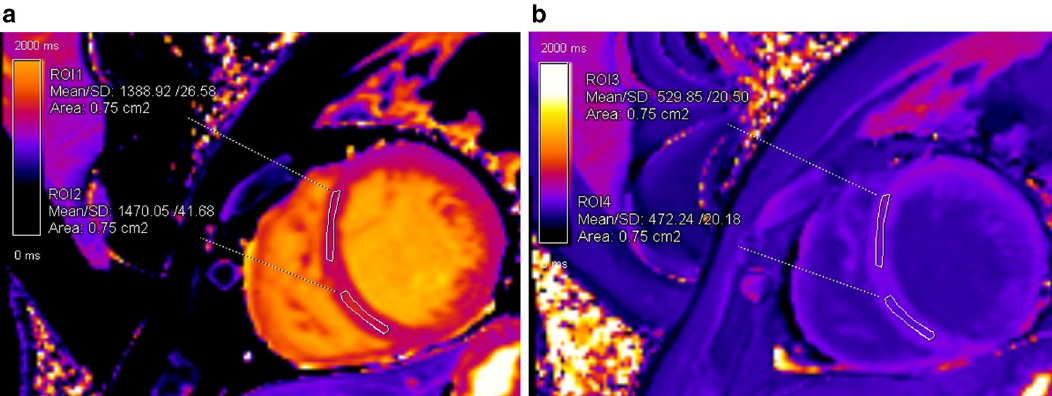
Figure 4. Native and post-contrast contours in the mid-myocardial area. The left ventricular cavity is shown (orange in native T1-mapping and dark-blue in post-contrast T1-mapping) to enable derivation of blood